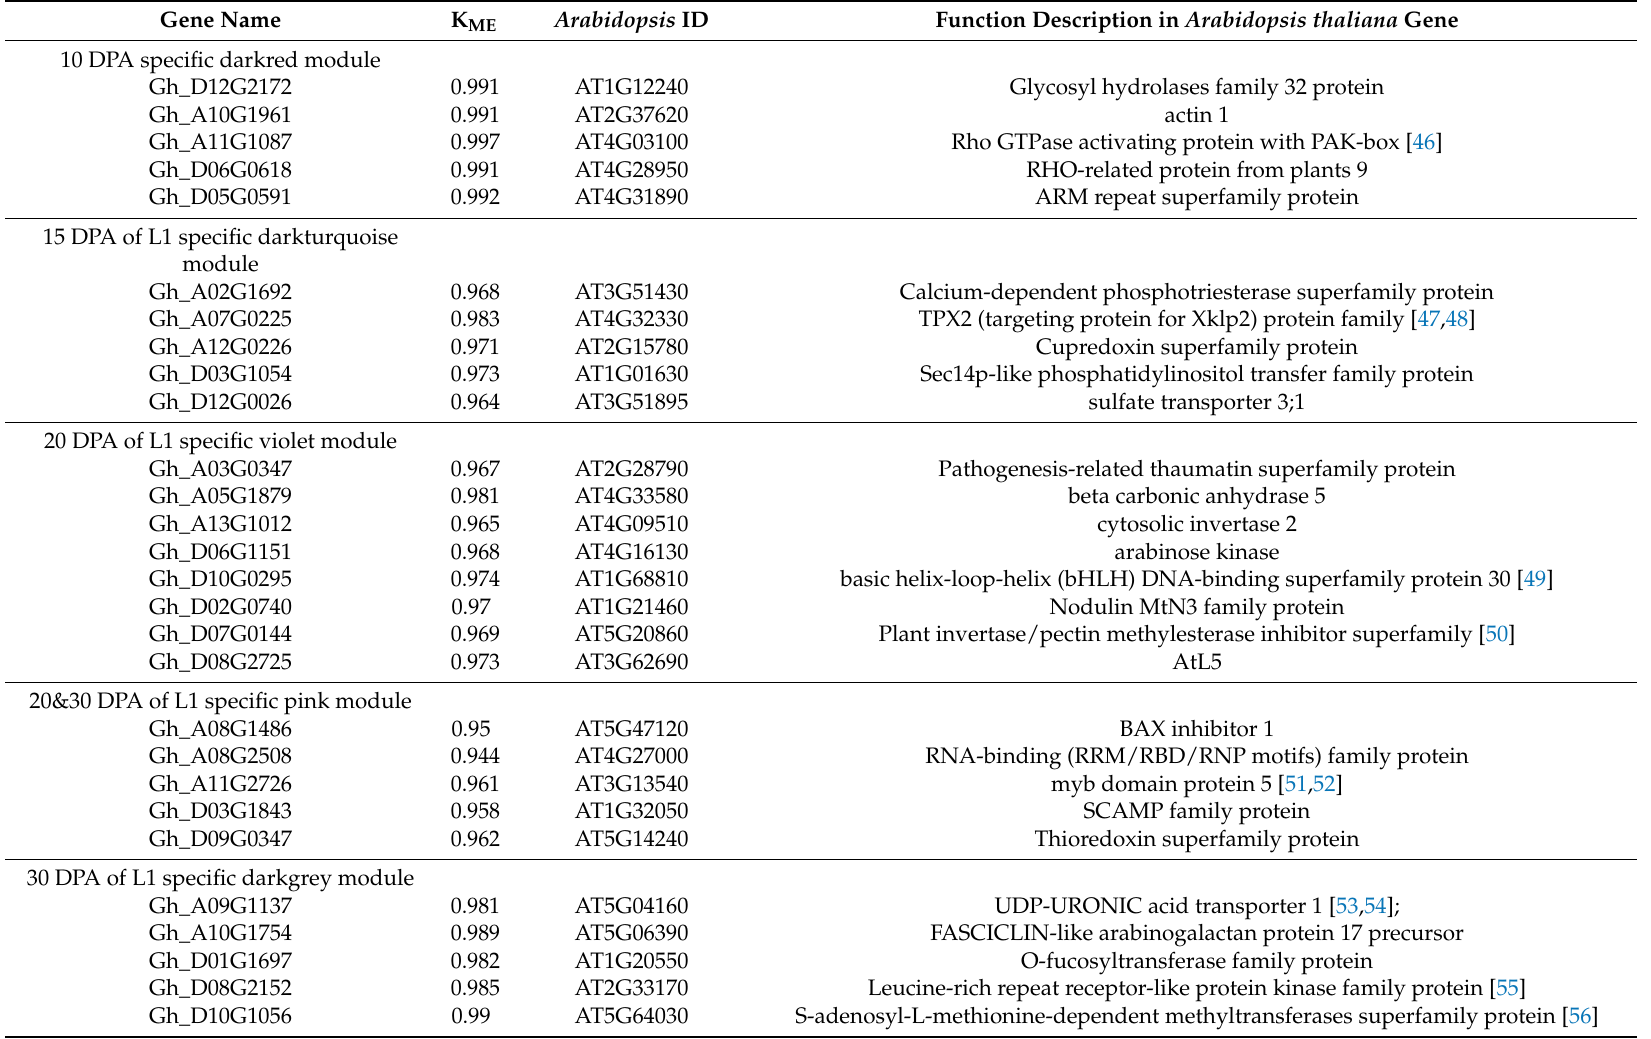
Table 5. Candidate hub genes in 10, 15, 20, and 30 DPA